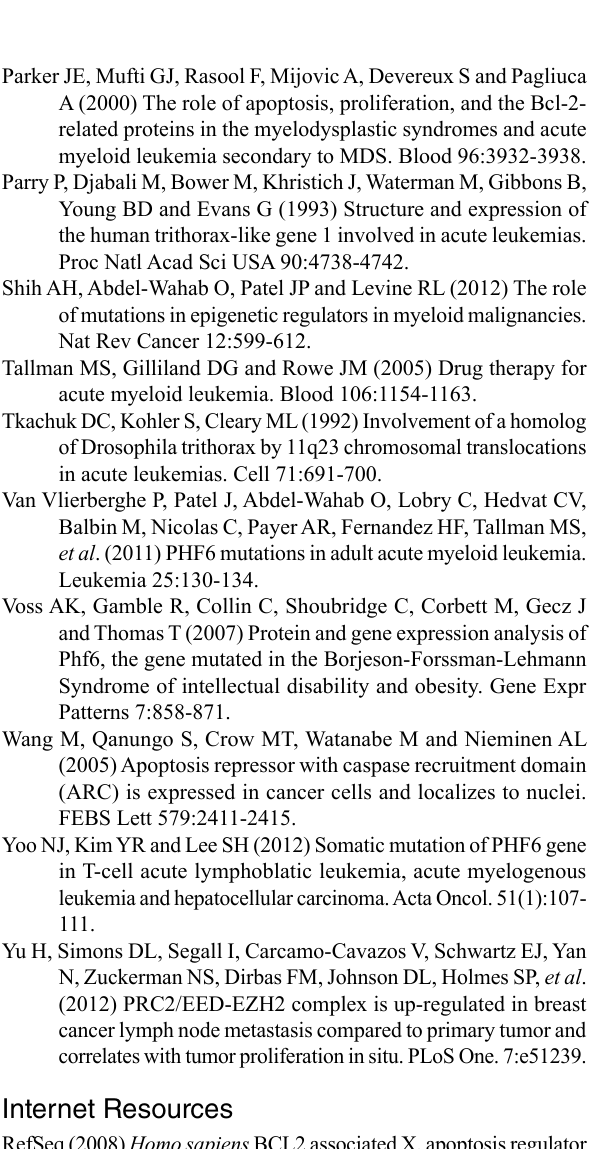
Table S1 - Clinical data of AML patients. Table S2 - Frequency of occurrence of cell surface